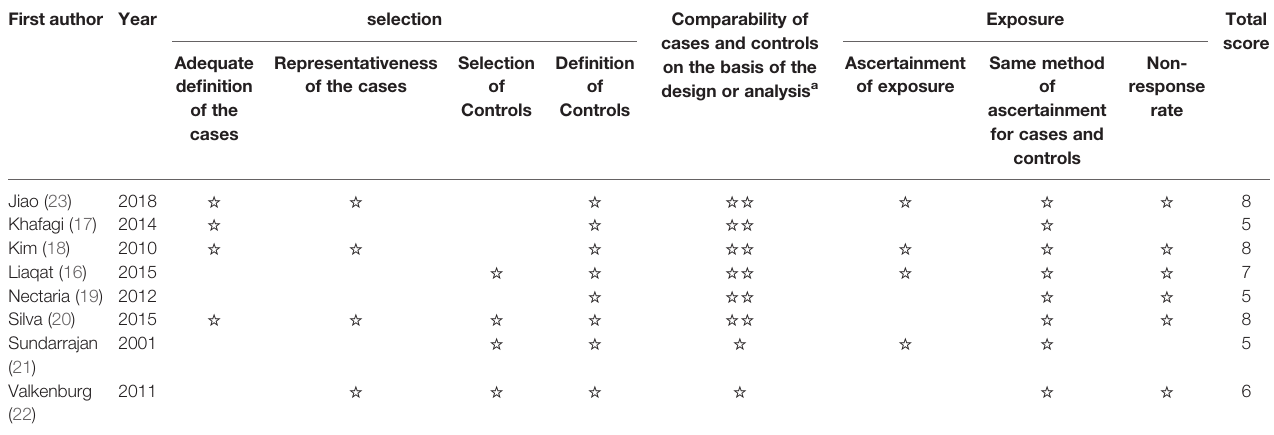
TABLE 2 | Methodological quality assessment of included